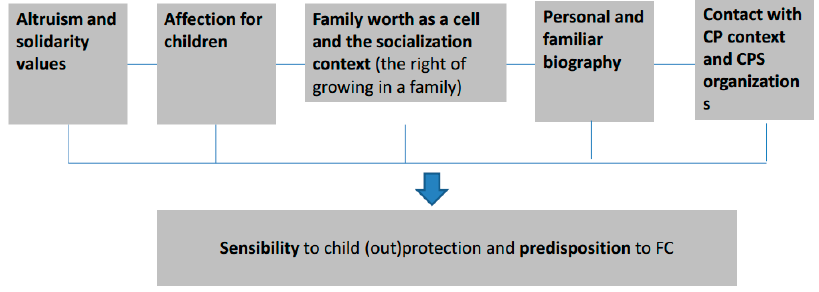
Figure 2. Predictors of the Motivation for Being a Foster Family.